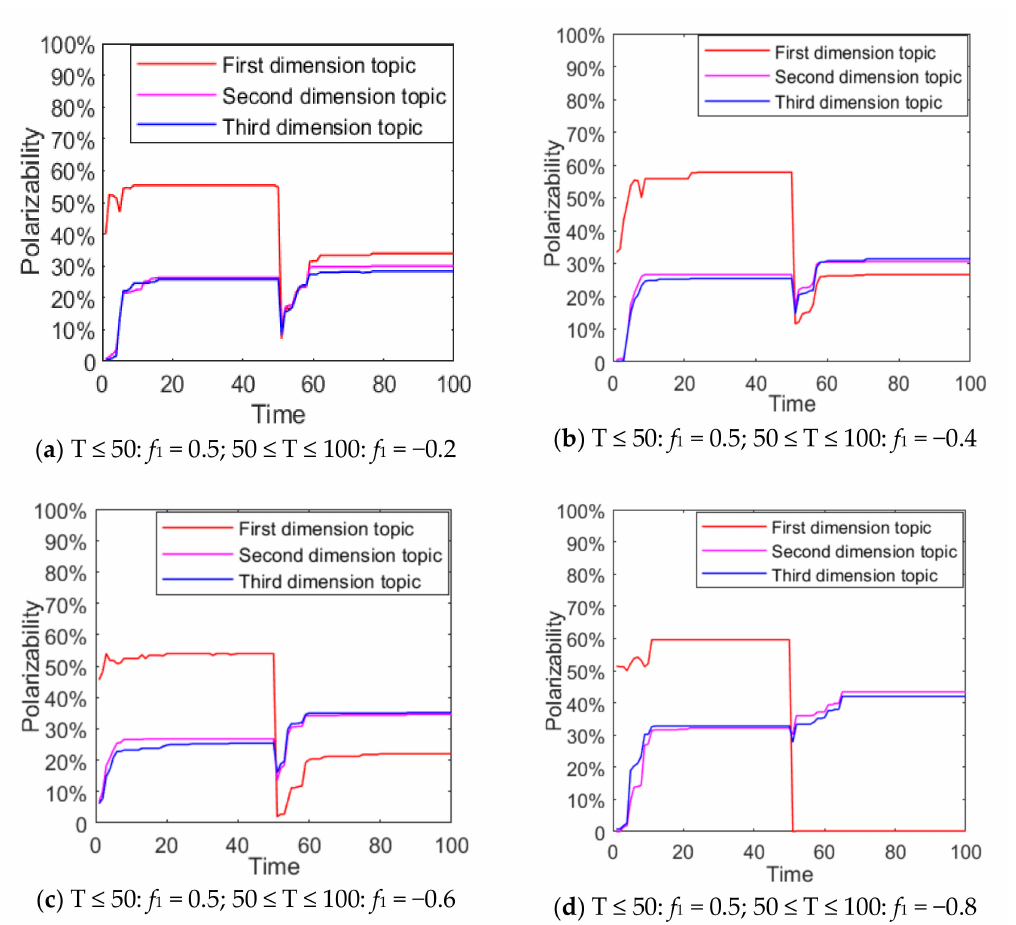
Figure 19. The polarizability curve of group attitude at different time under different information